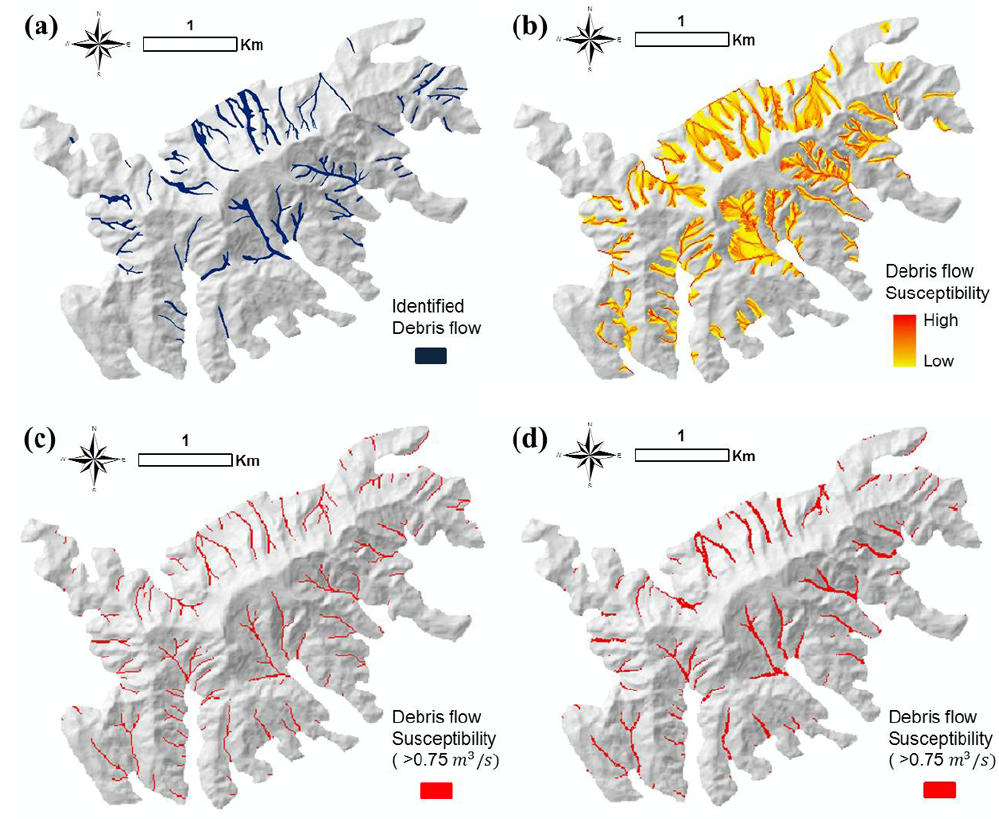
Fig. 15. Debris flow mapping and simulation results: (a) debris flow mapping in the study area, (b) Flow-R simulation result, (c) D-infinity method, and (d) multiple flow direction